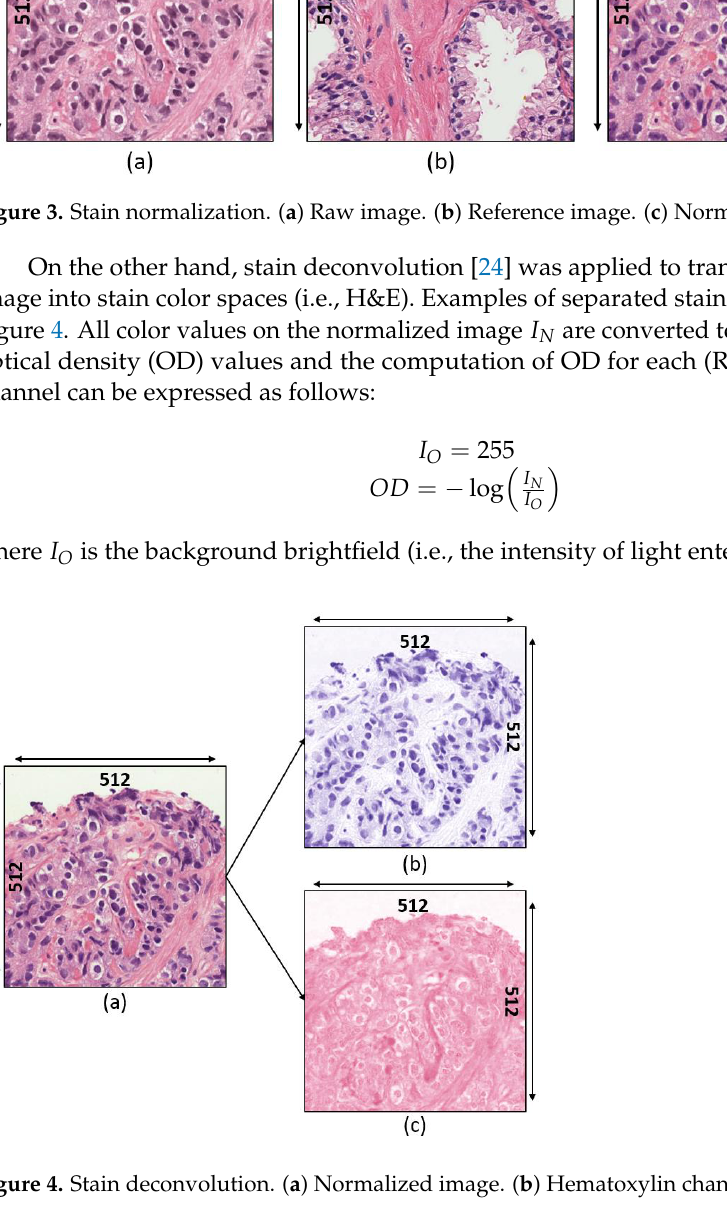
Figure 4. Stain deconvolution. ( a ) Normalized image. ( b ) Hematoxylin channel. ( c ) Eosin channel.